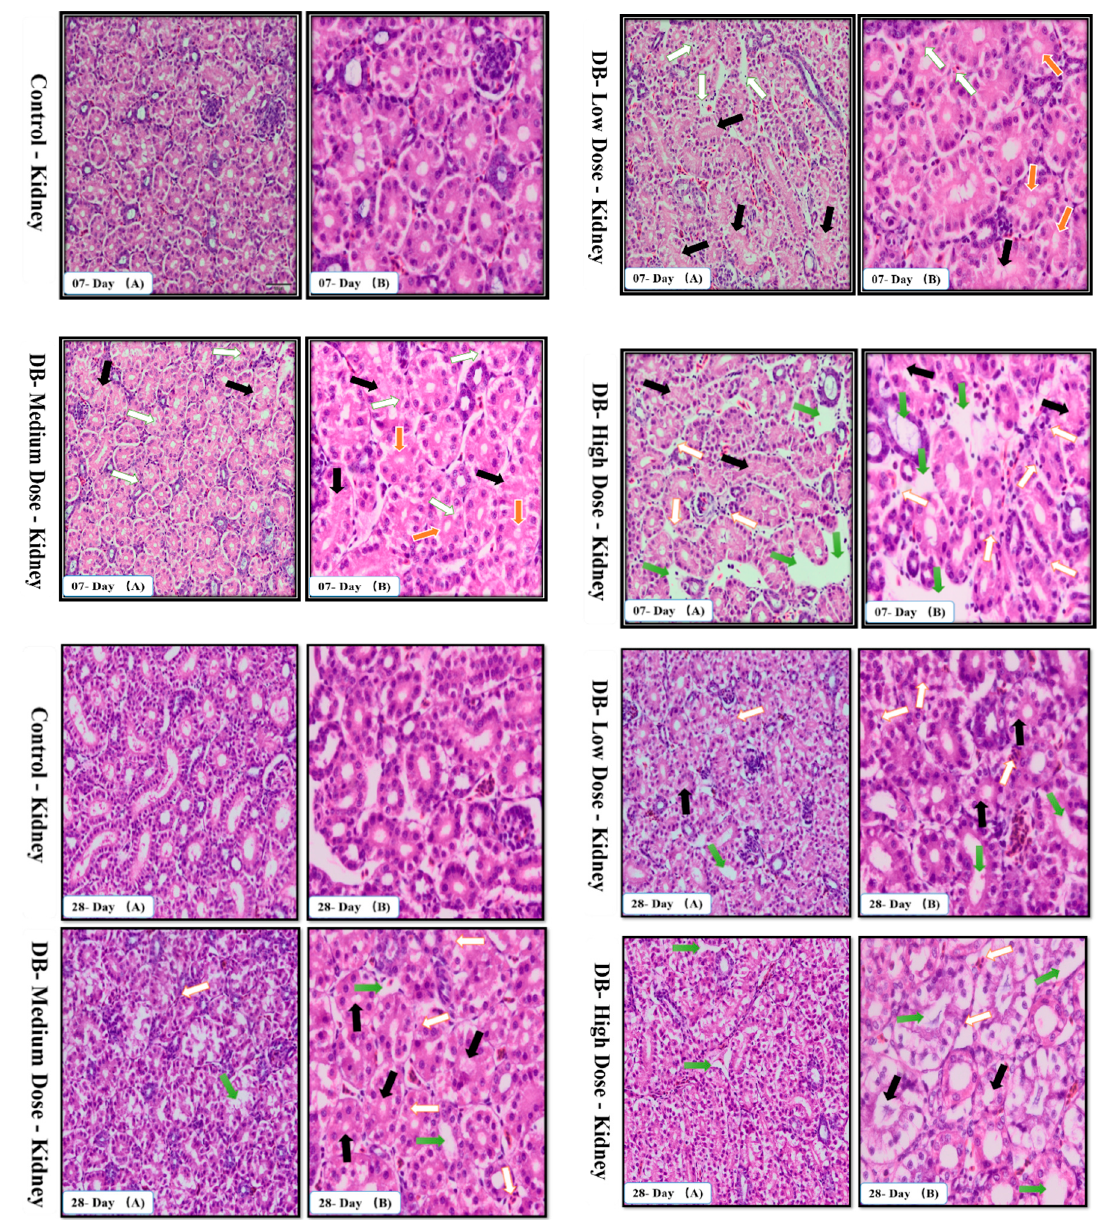
Figure 3. Effects of DB supplementation on the histomorphology of chicken kidney on day-07 and day-28 ( A-B ). On day-07, the black arrow shows that PCTs became swollen (hydrophiid degeneration). The white arrow indicates inflamed infiltrated cells and the green arrow indicates separation of the basement membrane of DCTs; Karyolysis occurred where no cells were found due to the toxic effects of DB. The effects on day 28 showed no major differences.